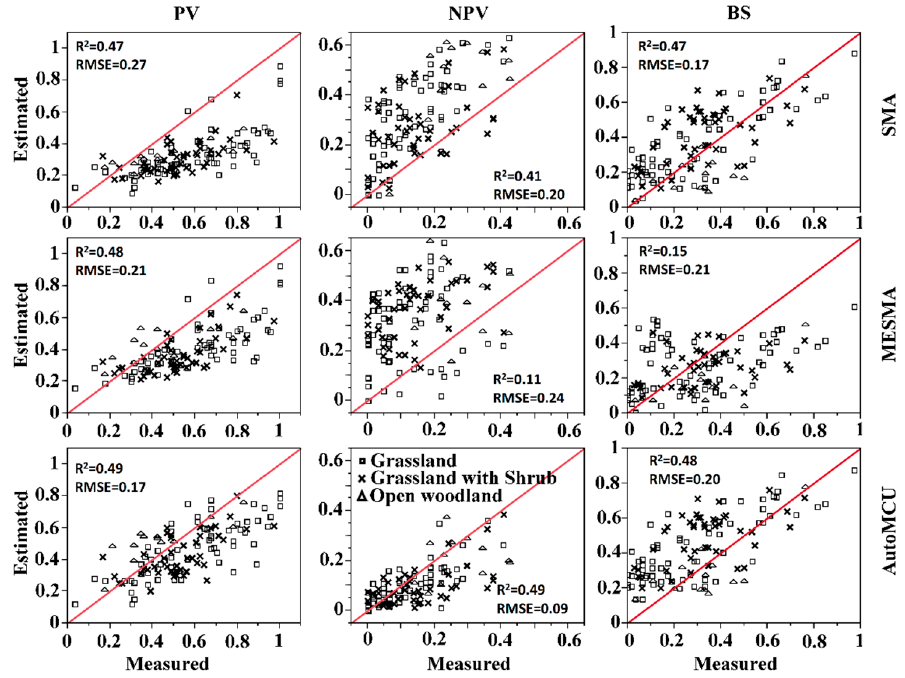
Figure 5. f pv , f npv and f soil estimation accuracy validation against field samples. Table 3. Regression analysis and validation of remote sensing results against observed data.